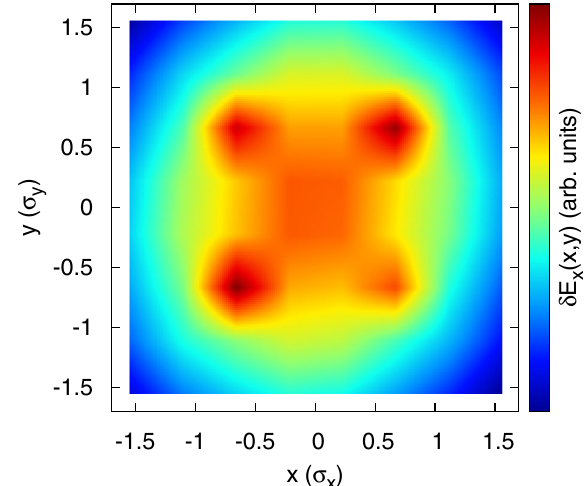
Eq. (5), for a round Gaussian beam. The exponential spatial dependence of the field fluctuations is superimposed by a grid texture caused by the mesh of the PIC solver. The simulation parameters are given in the